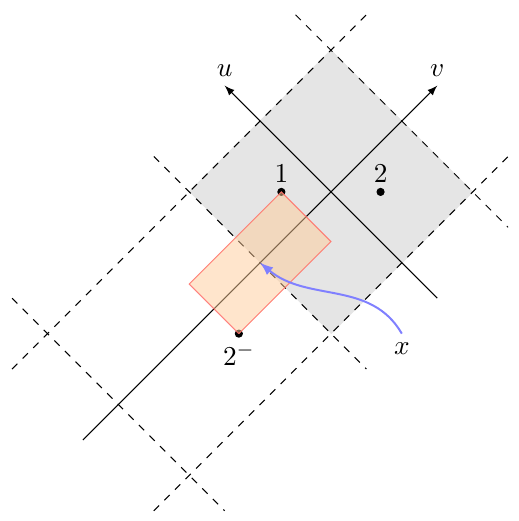
Figure 11 . The causal diamond 2 (cid:0) < x < 1 is shown in orange